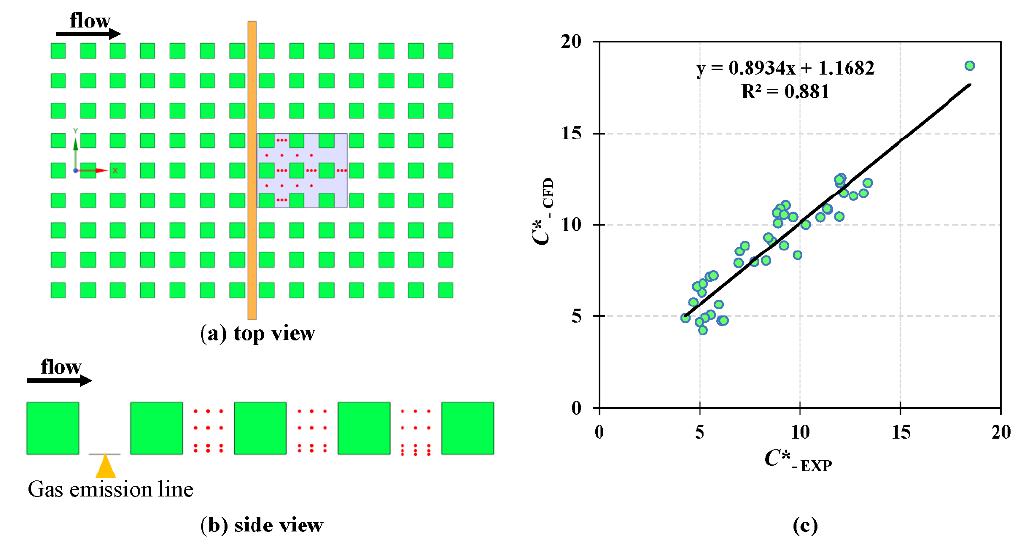
Figure 5. ( a , b ) Measuring points for the main simulation; ( c ) Correlation of C *.